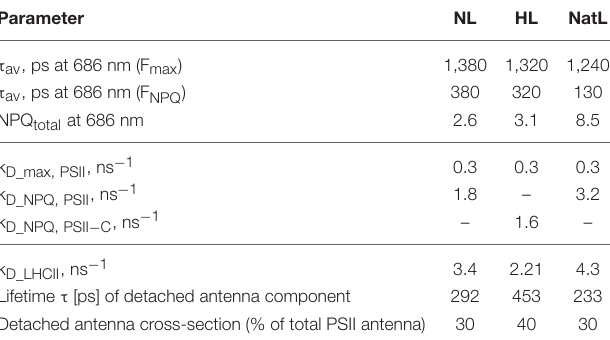
TABLE 4 | Average lifetimes and rate constants of F max and F NPQ components in NL, HL and NatL grown A. thaliana